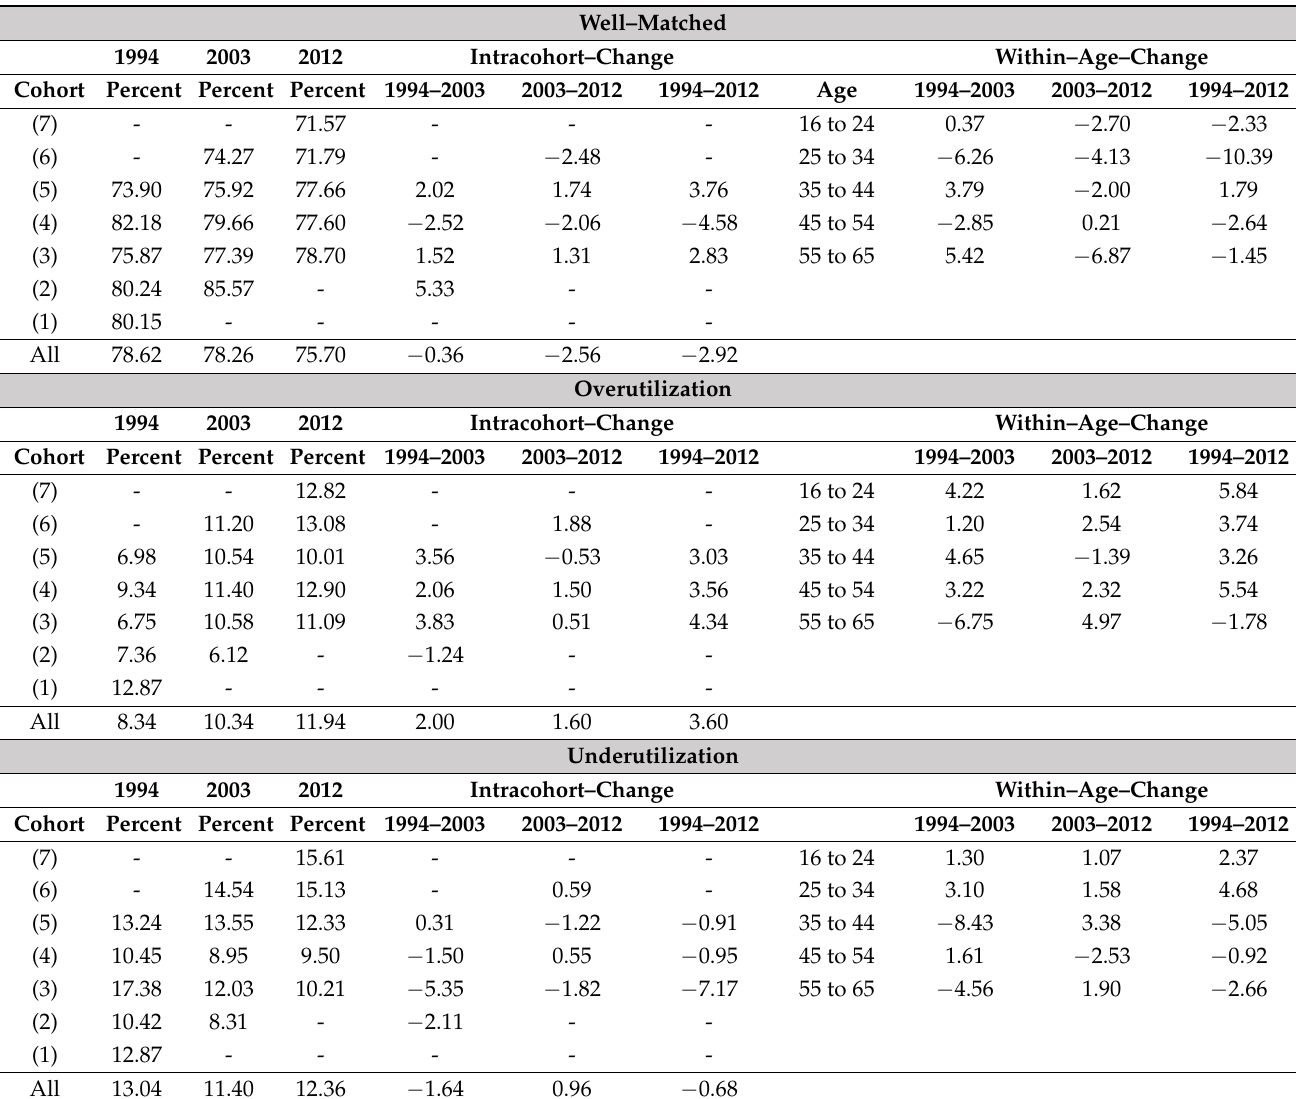
Table A2. The incidence and change of numeracy skill mismatch.